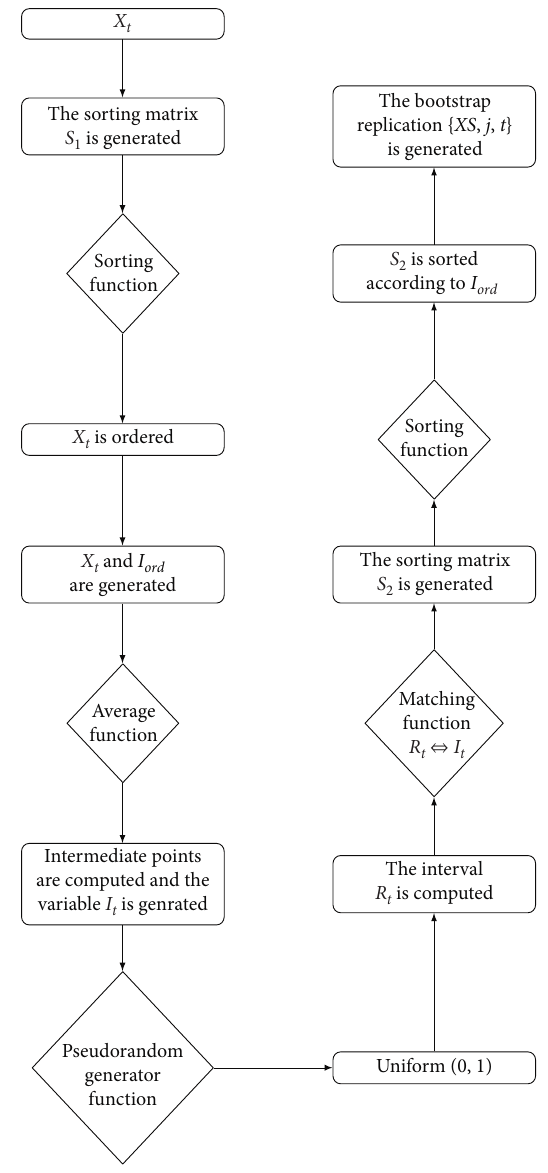
Figure 1: Flowchart of the MEBOOT